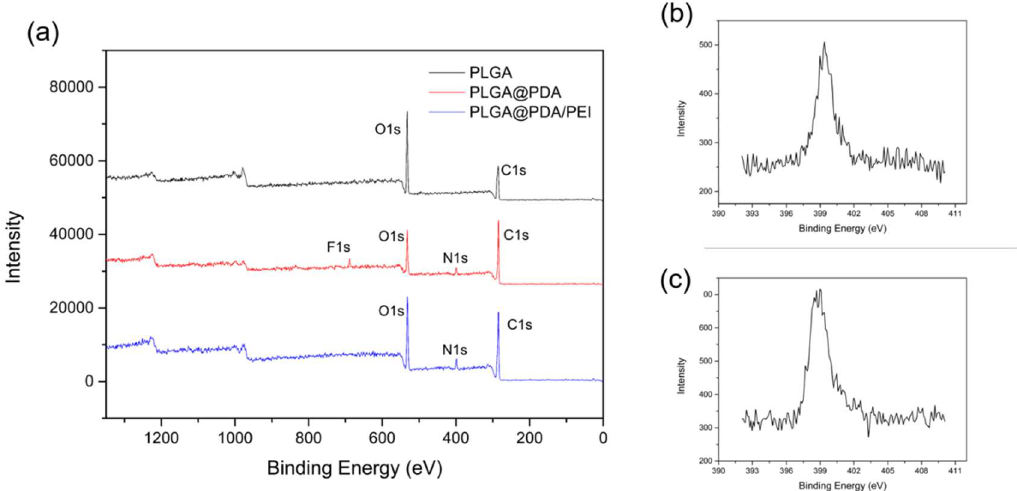
Figure 7. ( a ) The total XPS survey spectra of the PLGA microspheres, PLGA@PDA microspheres, and